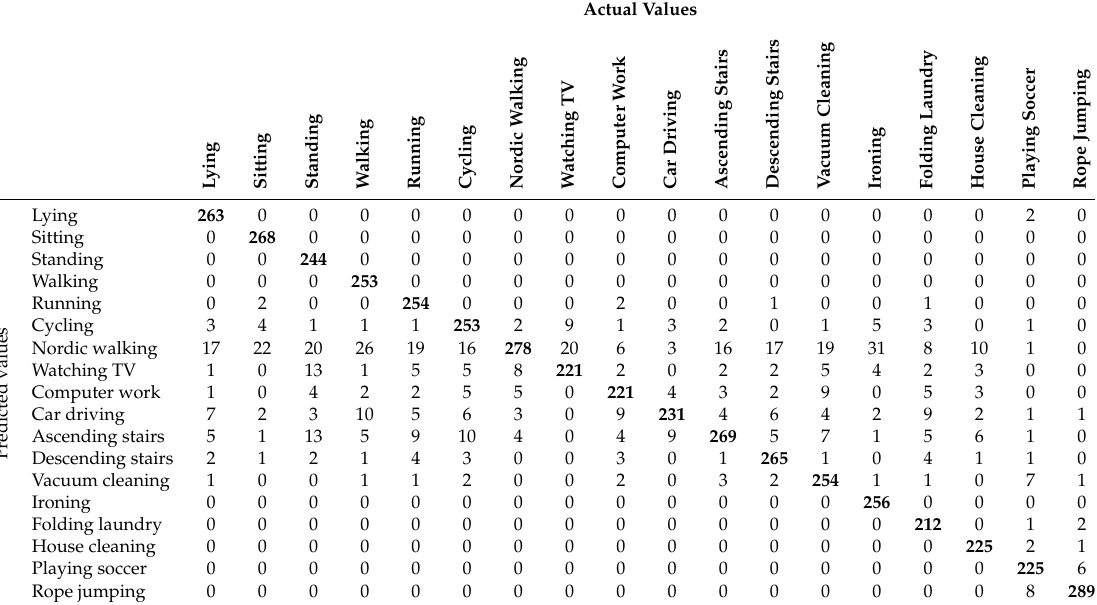
Table 17. Confusion matrix of the AHN classifier using the 30% noisy